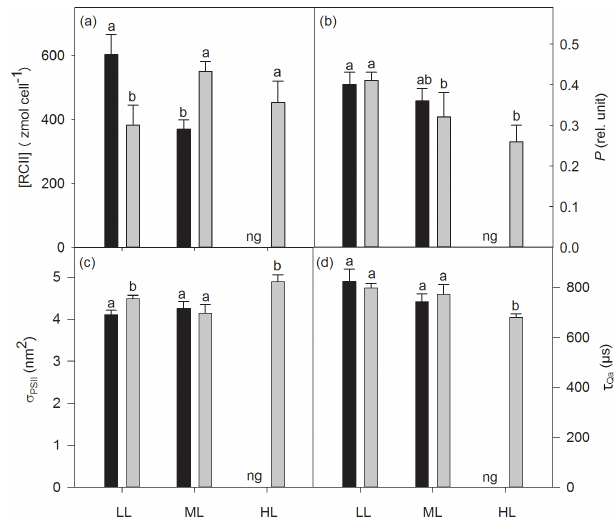
Figure 3. Cellular concentrations of functional photosystem II re- action centers [RCII] (a) , energy transfers between PSII units (i.e., connectivity, P ) (b) , functional absorption cross sections of PSII photochemistry ( σ PSII ) (c) and re-oxidation times of the primary electron acceptor Q a ( τ Q ) (d) were determined for Geminigera a cryophila acclimated to ambient or high CO 2 conditions combined with low (LL), medium (ML) or high light (HL). G. cryophila did not grow under ambient p CO 2 and HL as indicated by ng. Different letters indicate significant differences between treatments ( p < 0 .